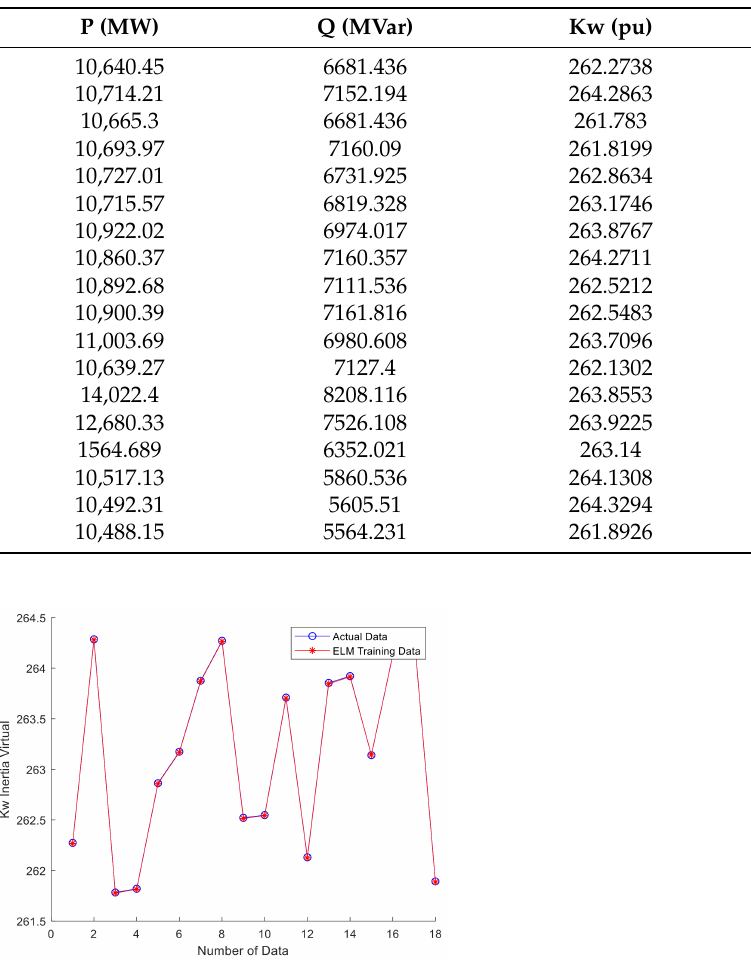
Figure 8. Comparison of actual Kw data and ELM Kw data.